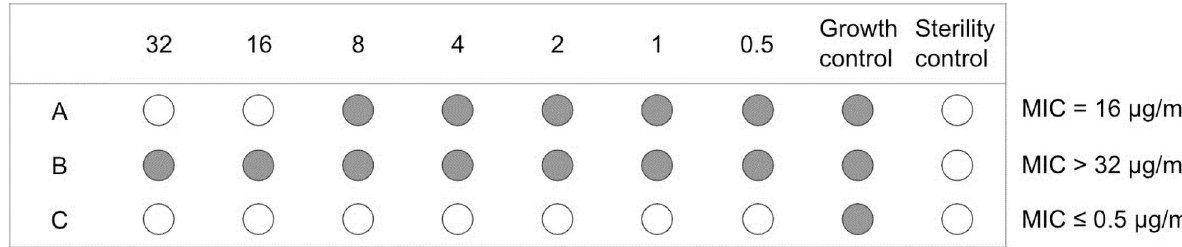
Fig 1. Schematic of the microtiter plate for broth microdilution experiment to determine the minimal inhibitory concentration (MIC) [5]. A: MIC is recorded as = the lowest concentration that inhibits visible bacterial growth; B: MIC is recorded as > the highest concentration when growth occurs in all dilutions; C: MIC is recorded as � the lowest concentration when no growth occurs in any concentrations.